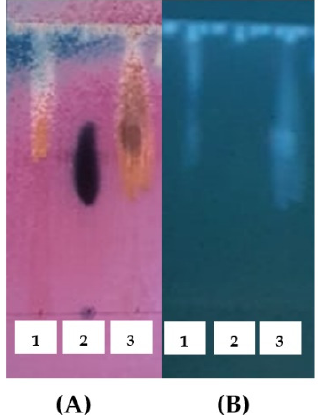
Figure 5. TLC analysis of glucose palm oleate synthesis from glucose and palm olein catalyzed by CPL. Lane 1; palm olein, lane 2; glucose, and lane 3; glucose palm oleate product. The TLC observation under ( A ) visible light and ( B ) UV light.